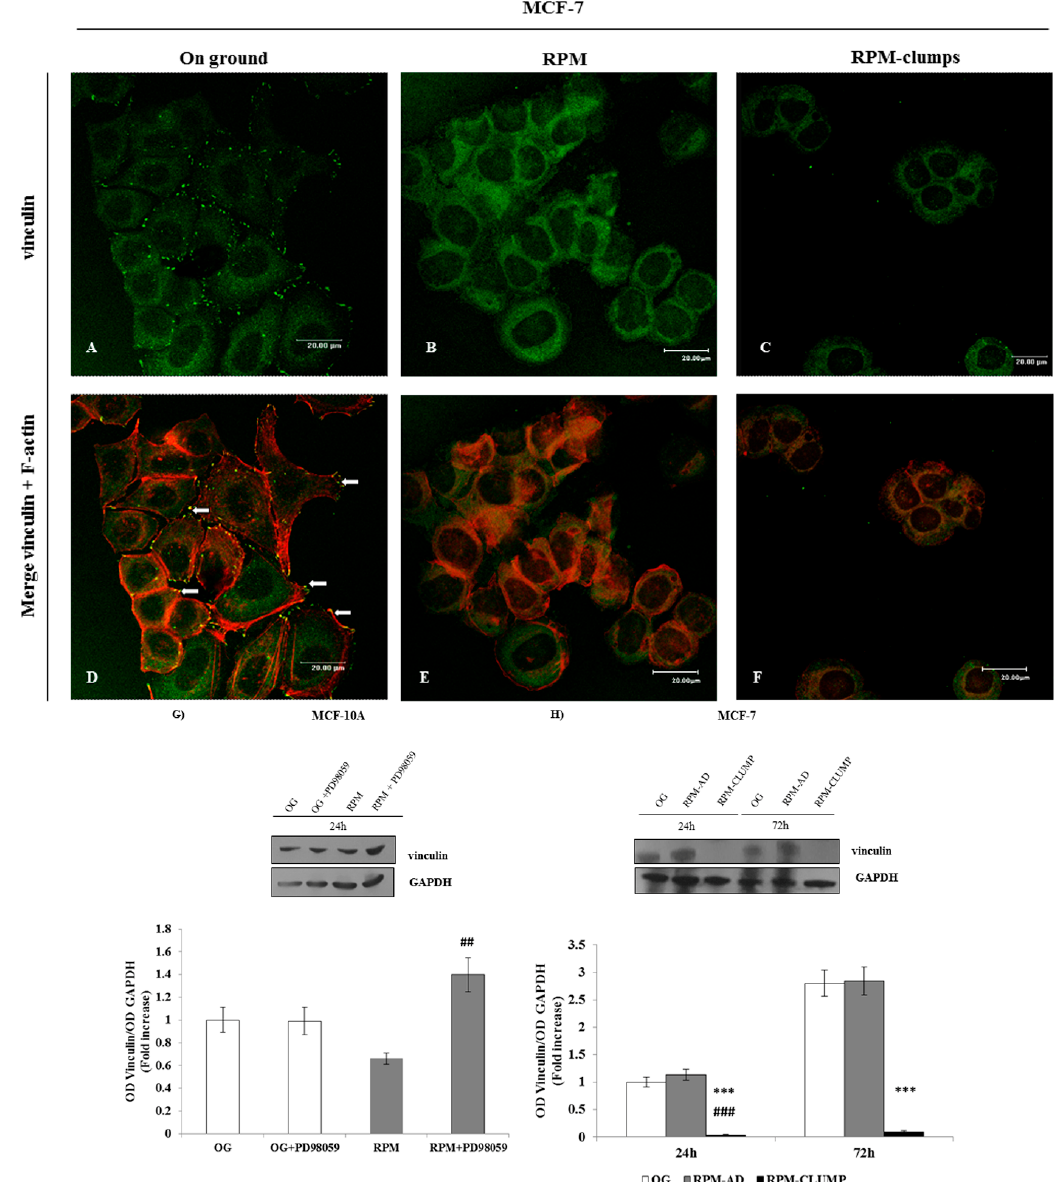
Figure 7. Confocal images of vinculin (green) and F-actin (red) distribution in MCF-7 cultured in normal gravitational conditions ( A , D ) and microgravity conditions ( B , E , C , F ) for 24 h. Vinculin distribution is localized nearby focal adhesion (FA) in MCF-7 cultured in the on-ground condition ( A – D , arrows). In MCF-7 RPM adherent cells, vinculin was recognizable within the cytosol and diminished in proximity plasma membrane ( B , E ). In MCF-7 RPM-CLUMP cells, vinculin was dramatically reduced and disappeared almost completely from the cytosol and plasma membrane ( C , F ). Scale bars 20 µm. Immunoblot bar chart ( G , H ) showing the expression of vinculin in MCF-10A ( G ) at 24 h (in correlation with the addition of p-ERK inhibitor PD89059) and in MCF-7 ( H ) in on-ground control cells, RPM adherent cells, and RPM cell clumps at 24 and 72 h. Data show that in MCF10A in microgravity, inhibition of phosphorylated ERK (pERK) leads to an increase in vinculin, while no effects are recorded in 1 g conditions. In MCF-7 cells, vinculin is severely reduced only in RPM-CLUMP cells. Columns and bars represent densitometric quantification of the optical density (OD) of a specific protein signal normalized with the OD values of the GAPDH serving as the loading control. Each column represents the mean value ± SD of three independent experiments. In MCF-10A, ## p < 0.01 vs. RPM by ANOVA followed by Bonferroni post-test. In MCF-7, *** p < 0.001 vs. OG; ### p < 0.001 vs. RPM-AD by ANOVA followed by Bonferroni post-test.